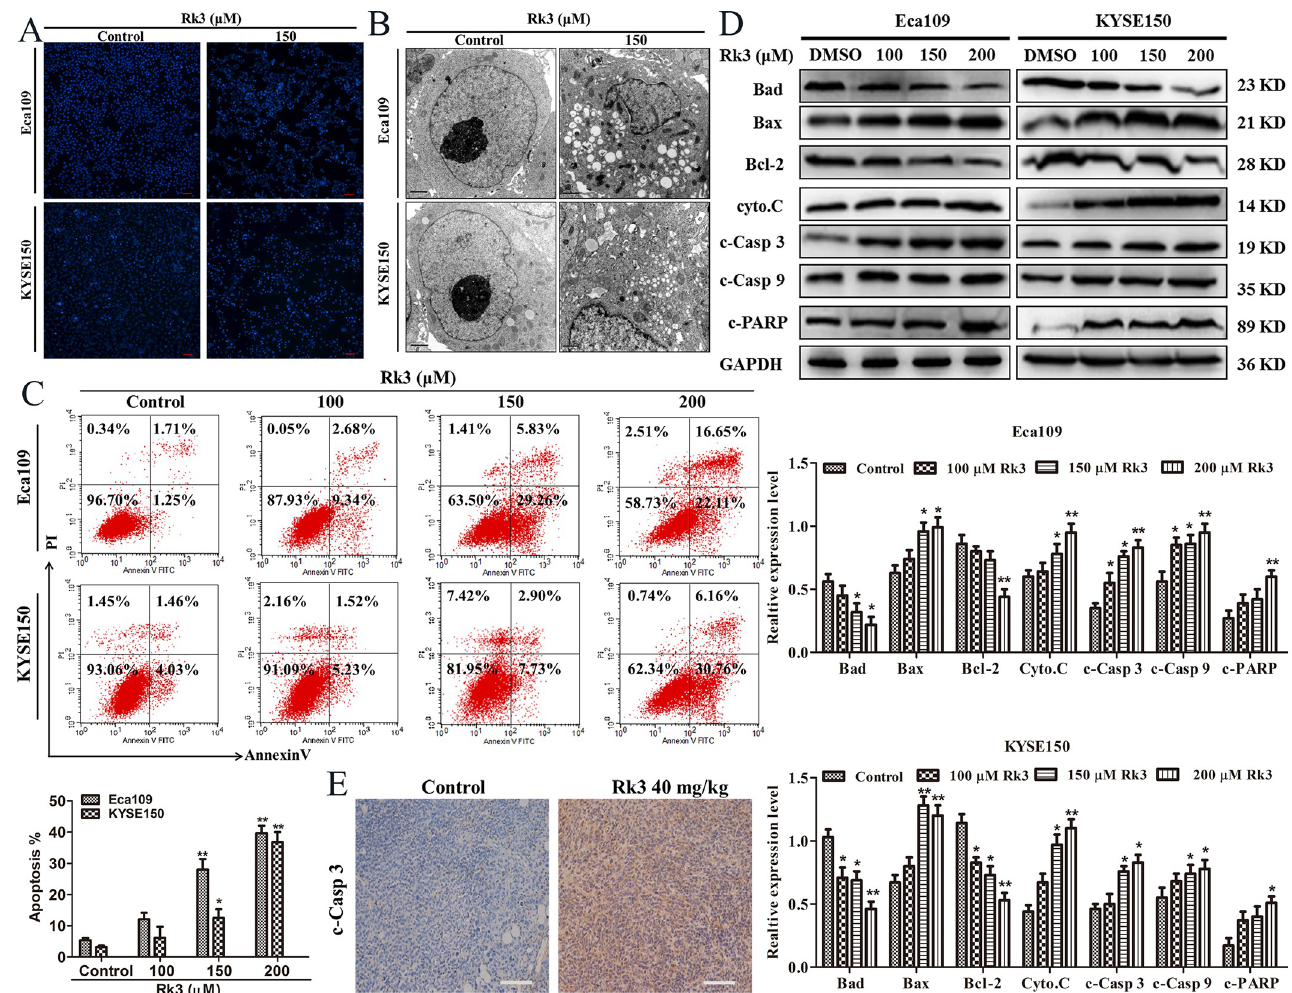
Fig 3. Rk3 induces apoptosis in Eca109 and KYSE150 cells. (A) Hoechst 33342 staining. Scale bar: 100 μ m. (B) Ultrastructure of apoptotic cells was observed by TEM. Scale bar: 1 μ m. (C) Apoptosis was quantified by flow cytometry. (D) Effect of different doses of Rk3 on the expression of apoptosis-related proteins after treatment for 24 h. (E) Immunohistochemistry staining of tumor tissue. � p < 0.05, �� p < 0.01 compared with control.